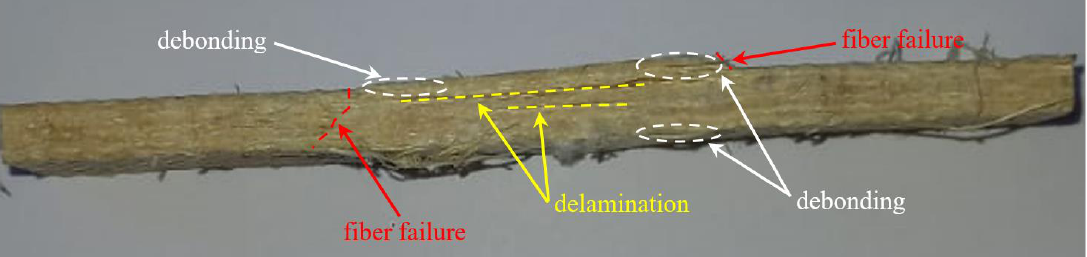
Figure 12. Typical SFRP specimen failure after tensile test.